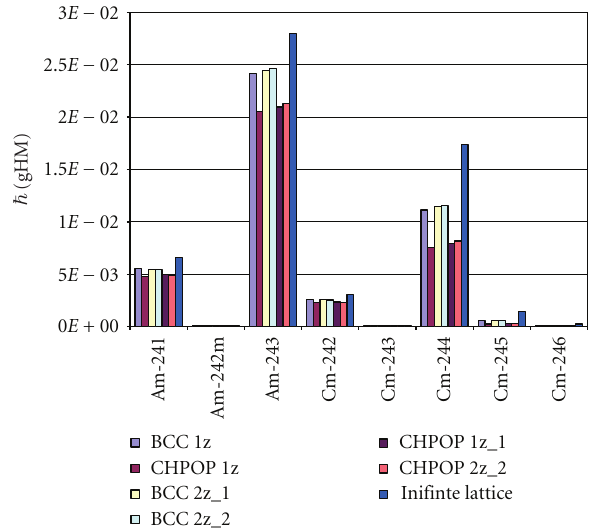
Figure 6: Production (grams) of Am and Cm nuclides per initial HM mass in the di ff erent PBMR core models (after 1063